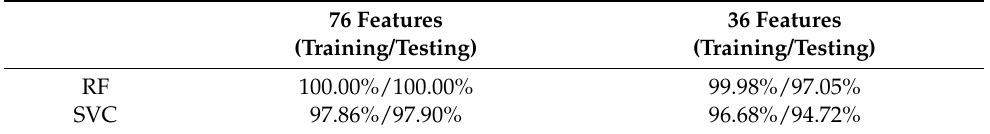
Table 12. Binary classification accuracy (CSE-CIC-IDS 2018).